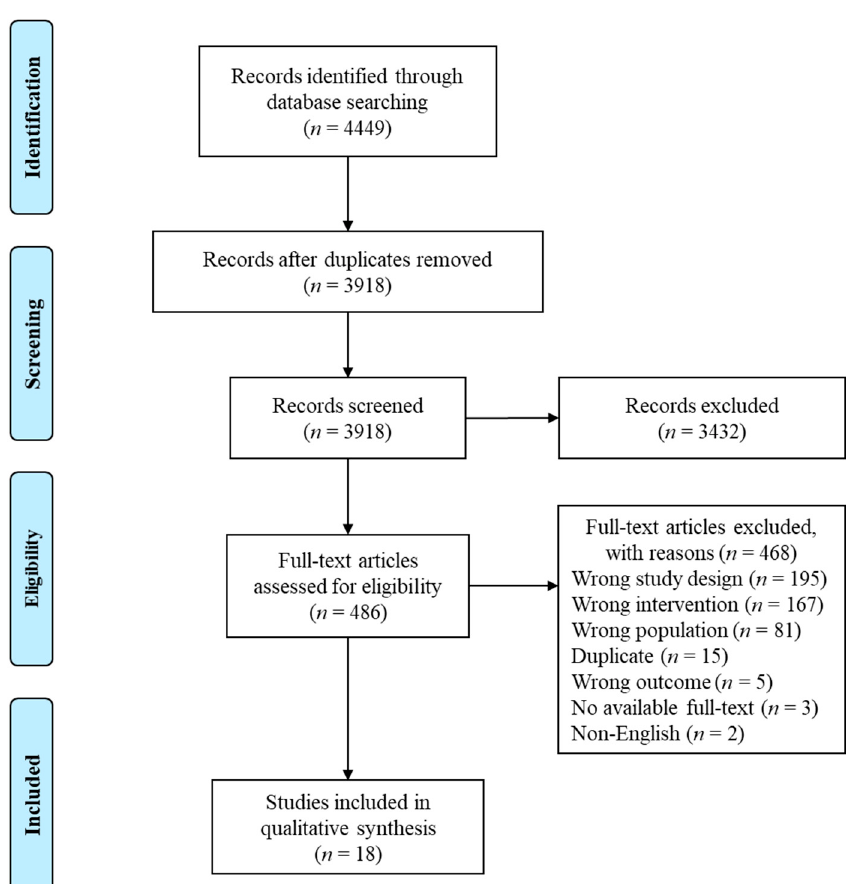
Figure 1. PRISMA flow diagram. Table 1. Study characteristics ( n = 18 studies).